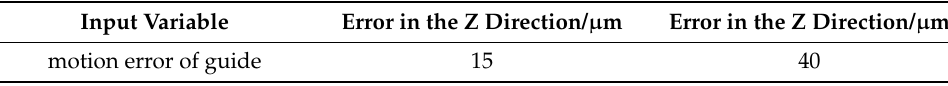
Table 5. Motion errors of the machine tool guide. Table 4. Input vibration variables of the simulation model.